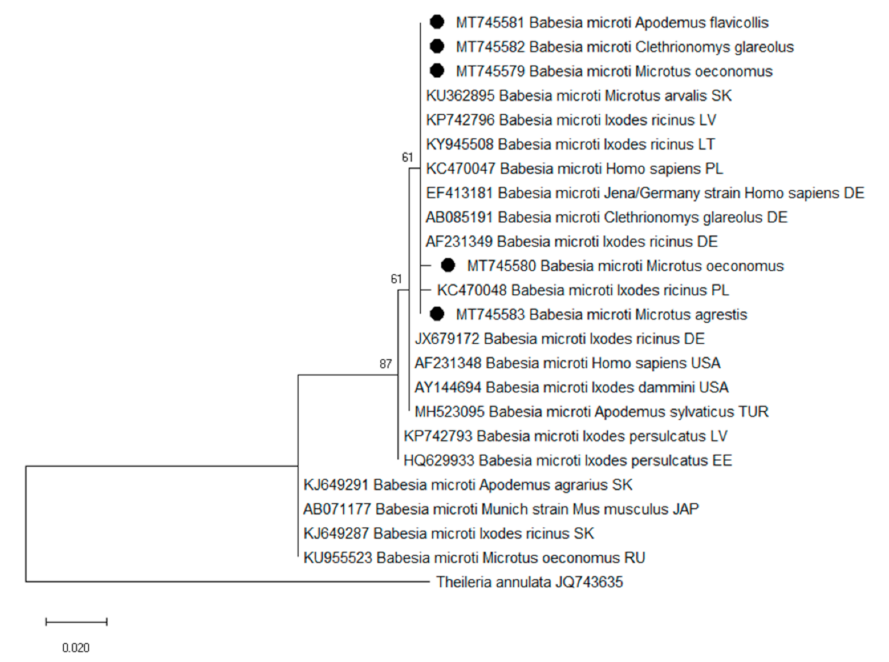
Figure 4. Phylogenetic tree of the partial 18S rRNA gene of Babesia microti inferred by ML method, the Tamura–Nei model and bootstrap analysis of 1000 replicates. Marked with dark circle are samples sequenced in the present study. Sequences MT745579 and MT745581 are representative of six and five other samples obtained in this study (from A. flavicollis and M. oeconomus ), respectively. Sequences MT745582 and MT745583 are representative of two and one other samples sequenced in the present study (from C. glareolus and M. agrestis ),